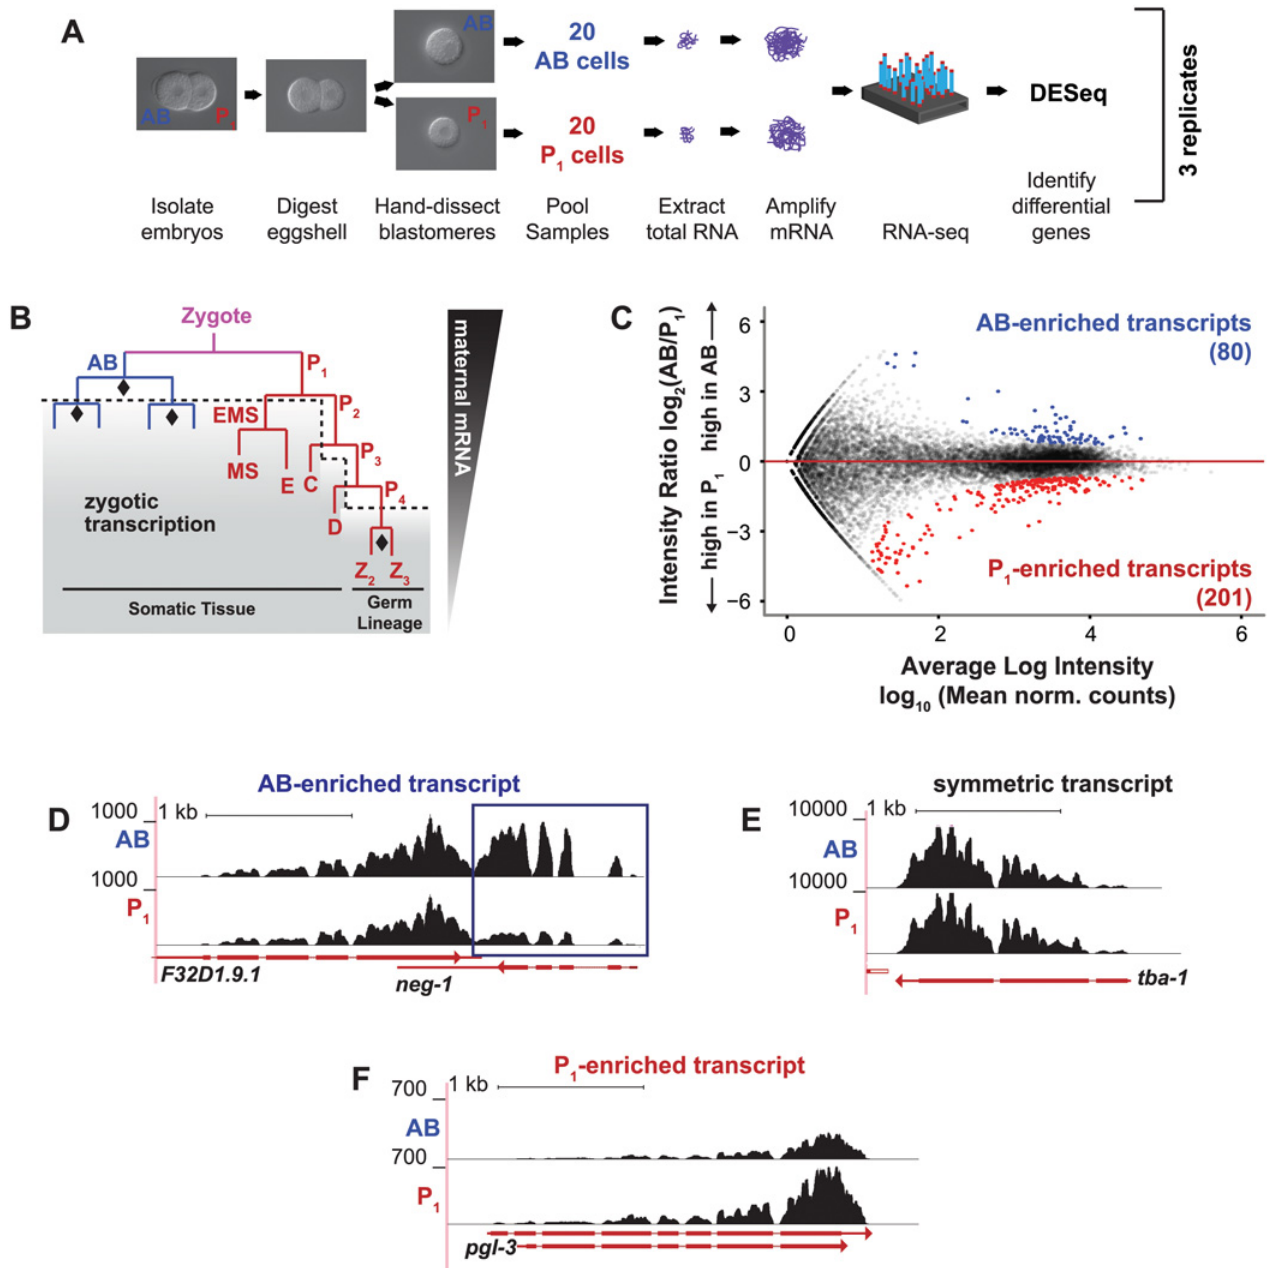
Fig 1. Differential transcript abundance in AB and P 1 blastomeres following the first embryonic division. (A) C . elegans wild type embryos were harvested from gravid adults. AB and P 1 blastomeres were separated by microdissection, and mRNA was extracted, amplified and sequenced. (B) The first cell division is asymmetric and creates the anterior AB cell and posterior P 1 cell. RNA in the AB and P 1 cells is exclusively maternal prior to the onset of zygotic transcription (dashed line, shading). Symmetric cell divisions are marked by diamonds. (C) For each gene, the normalized ratio of RNA-seq read counts between P 1 and AB is plotted against the mean normalized read count for each transcript (Materials and Methods). Asymmetrically abundant transcripts are shown in blue (AB-enriched) and red (P 1 -enriched). (D) RNA-amp-seq traces for an AB-enriched transcript ( neg-1 , boxed in blue) (E) Same as D for a symmetric transcript ( tba-1) (F) Same as D for a P 1 -enriched transcript ( pgl-3) .